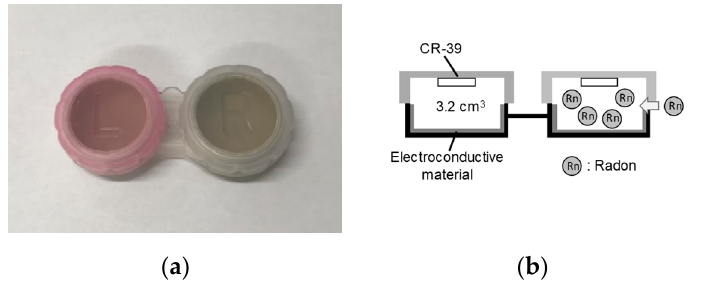
Figure 1. External view of the passive radon personal monitor constructed using a small container for storing contact lenses ( a ) and a schematic representation of the monitor ( b ).